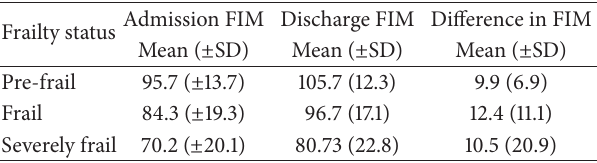
Table 2: Comparing admission, discharge, and difference in func- tional improvement across frailty status.